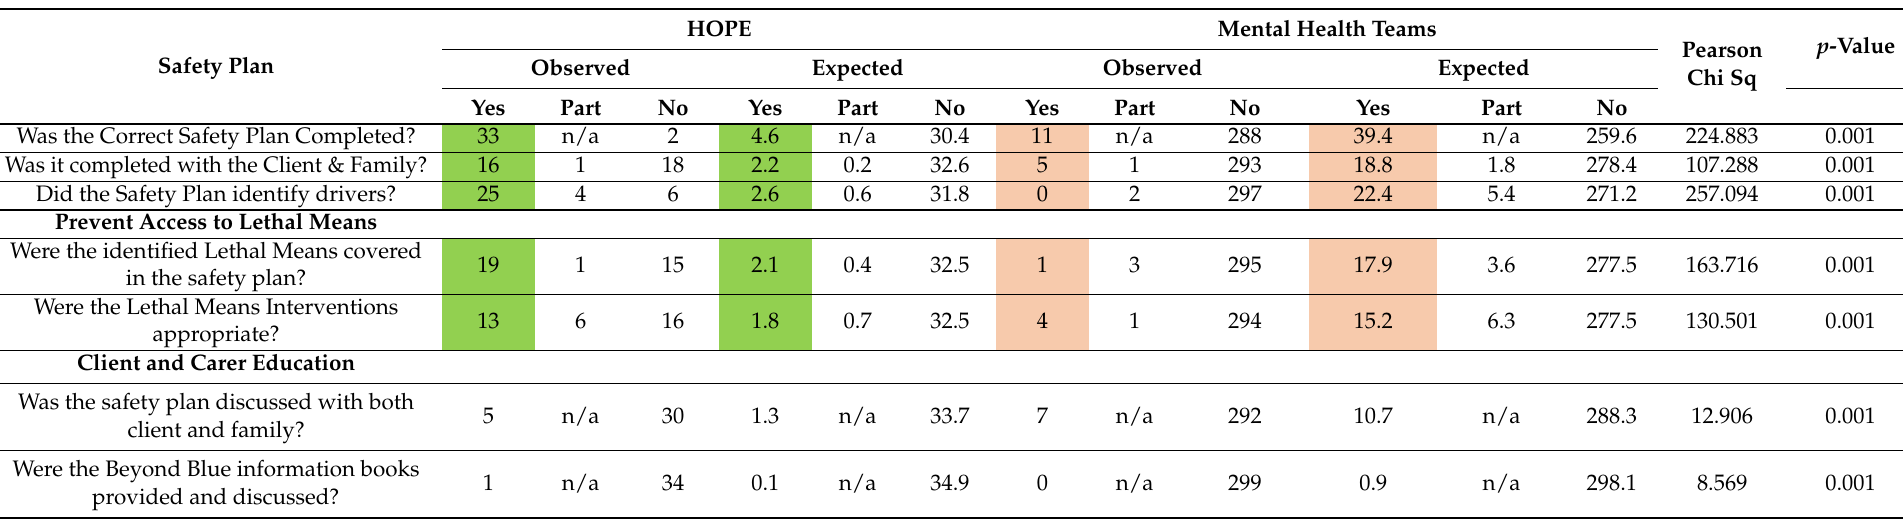
Table 5. Safety planning, prevention of access to lethal means and client and carer education. Assessment. Key—Green: above expected and Orange: below